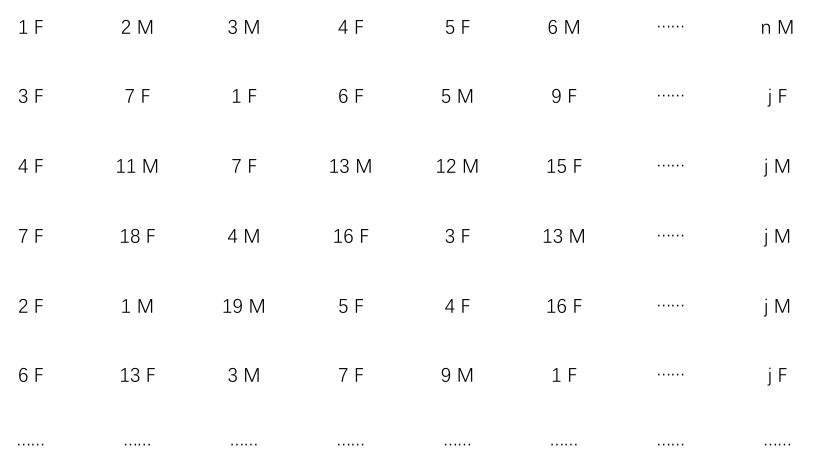
Figure 4. Permutations and combinations of vehicle